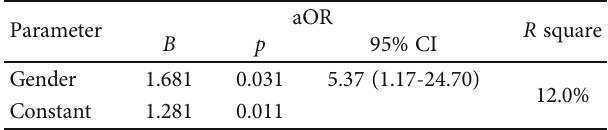
Table 5: Multivariate analysis of single intracranial aneurysm and rupture risk.